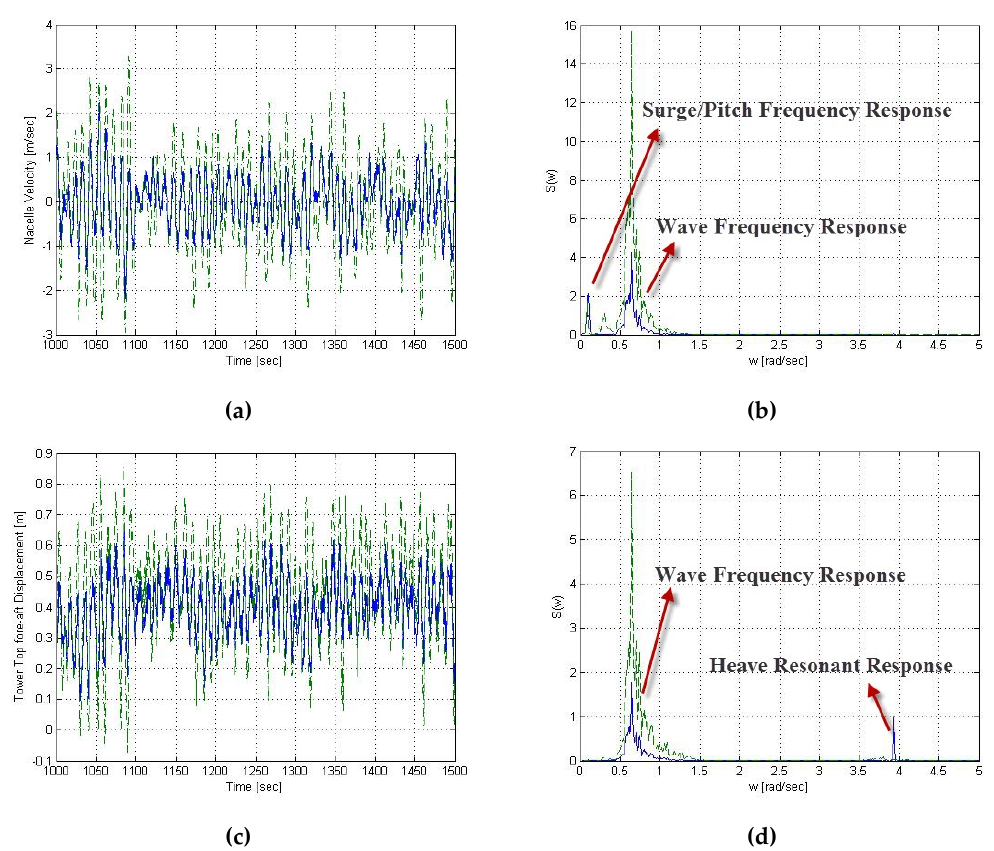
Figure 13. Tower top displacements of SWAY swivel model and reference model. (Solid blue: SWAY model; Dash green: reference hinged model): ( a ) Nacelle velocity time series. ( b ) Nacelle velocity spectrum. ( c ) Nacelle acceleration time series. ( d ) Nacelle acceleration